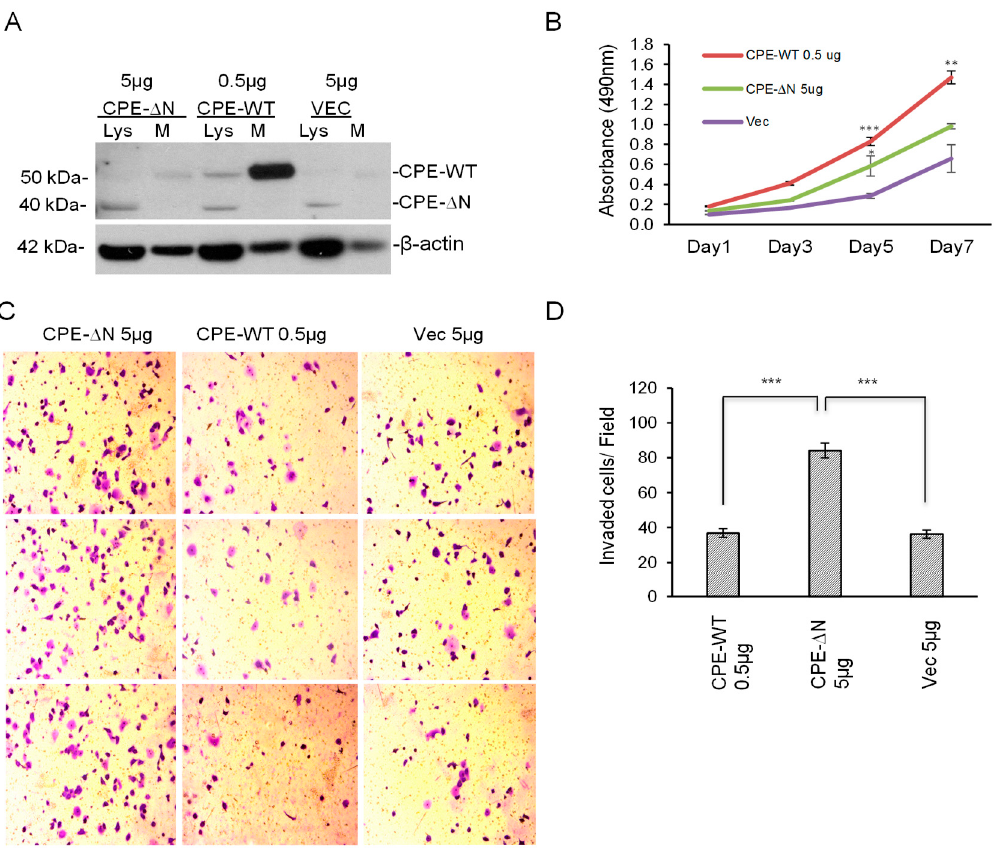
Figure 3. CPE- ∆ N enhances proliferation and invasion of Panc-1 cells. ( A ) Western blot analysis of cell lysates (Lys) or secretion media (M) of Panc-1 cells transfected with 5 µ g or 0.5 µ g of the plasmid (as indicated) carrying construct for 40 kDa CPE- ∆ N, CPE-WT or vector control for 24 h. β -actin was used as the loading control for the cellular lysates. Note that β -actin bands in the media fraction cannot be considered as a loading control and is possibly the result of minimal cell lysis before supernatant media collection. Full-length blots are presented in Supplementary Figure S2C,D. ( B ) A line graph of an MTT assay showing proliferation of Panc-1 cells expressing 40 kDa CPE- ∆ N, CPE-WT, or vector control (Vec) from Day 1–5. ( N = 1, n = 3, ** p < 0.01 *** p < 0.001). ( C ) Representative images of Panc-1 cells in Matrigel invasion assay 24 h after transfection with 40 kDa CPE- ∆ N, CPE-WT, or vector control. ( D ) Bar graph showing increased invasion of Panc-1 cells expressing 40 kDa CPE- ∆ N compared to vector control ( N = 1, n = 3, *** p < 0.001). Error bars denote SD.